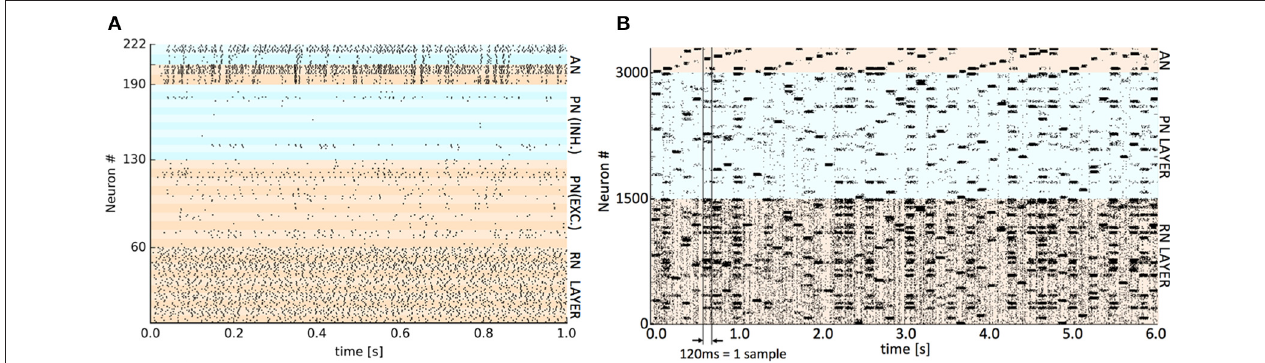
FIGURE 2 | Representative spike raster plots of classification of a test set at two levels of detail. (A) Detail of spikes occurring during 1s presentation of a single test digit to the trained Spikey classifier using 10 virtual receptors. The banding discriminates individual populations of 6 or 8 neurons. The colors distinguish the main layers (bottom to top): RN layer (0–59), PN and lateral inhibitory LN neurons (60–129 and 130–189), AN output neurons and paired lateral inhibitory LN neurons (190–205 and 206–222). High activity in the upper AN population determines the classification decision. (B) The trained SpiNNaker classifier using 50VRs and all 10 digits (0–9). Spiking activity occurring during consecutive 120ms presentations of 50 × MNIST test digits ordered cyclically 0–9. The colors distinguish the main layers (bottom to top): RN layer (50 clusters of 30 neurons), PN layer (50 clusters of 30 neurons) and at the top, AN output neurons (10 clusters of 30 neurons). A perfectly regular “sawtooth” pattern of activity in the output would imply 100% classification. A similar representative raster plot from GeNN is available as Supplementary Material.